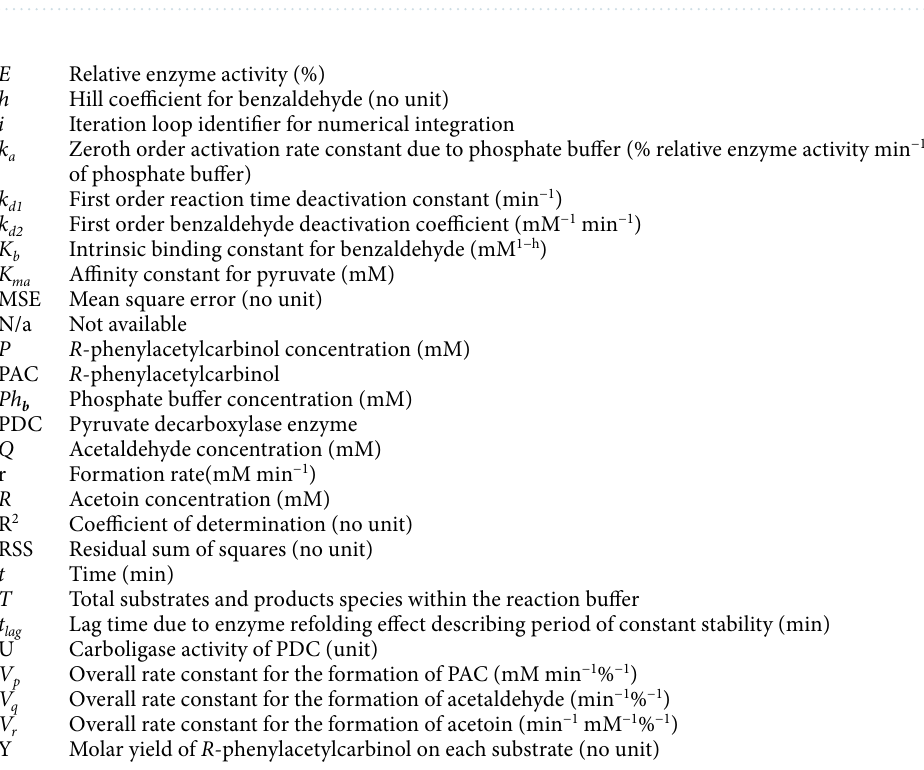
Figure 1. Schematic reaction mechanism of proton consuming PAC biotransformation from benzaldehyde and pyruvate substrates catalyzed by PDC with Mg 2+ and thiamine pyrophosphate (TPP) as cofactors. The structures of acetaldehyde and acetoin by-products, resulting from direct decarboxylation of pyruvate generating free acetaldehyde and subsequent carboligation reaction of active acetaldehyde and free acetaldehyde, are also included (modified from Leksawasdi et al. 18–20